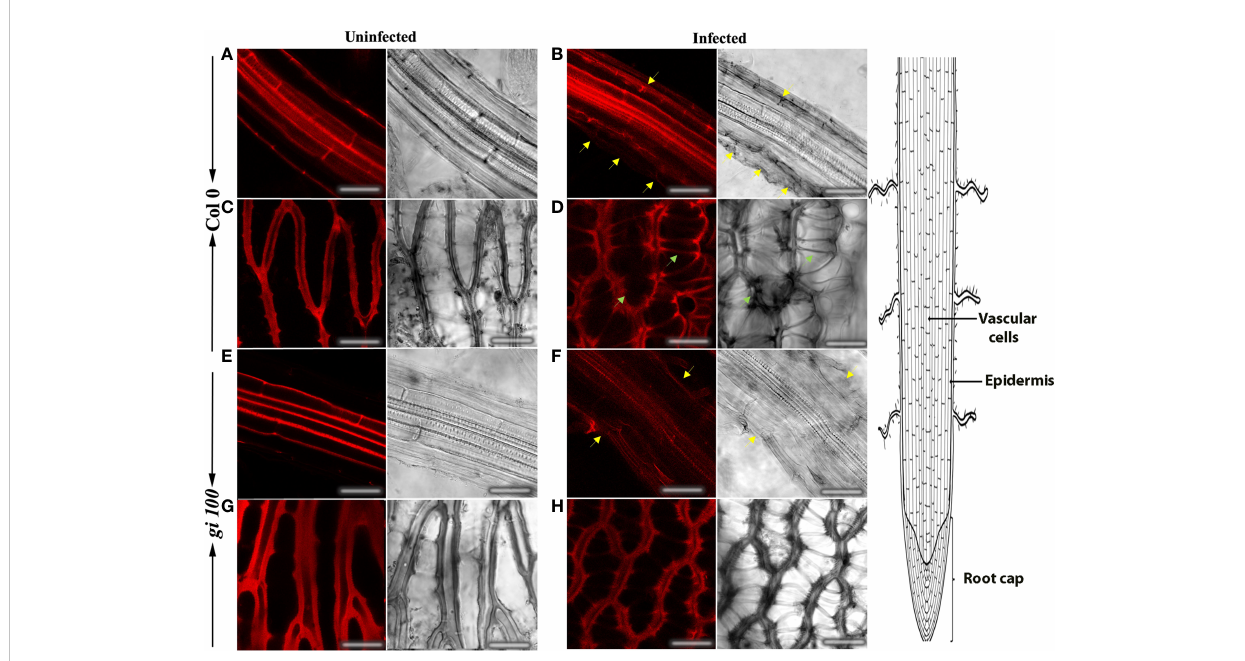
FIGURE 6 Effect of F. oxysporum infection on root cells in Arabidopsis thaliana using propidium iodide. Concurrent confocal fl uorescence and transmitted light images of uninfected and infected roots from Col-0 (A – D) and gi-100 (E – H) at 9-DPI stained with propidium iodide. Epidermal cell wall showed structural deformities in infected Col-0 (B) and gi-100 (F) (yellow arrows). Columella cells showed structural irregularities in cell shape of infected Col-0 (green arrows in D ). Scale bar, 100 m